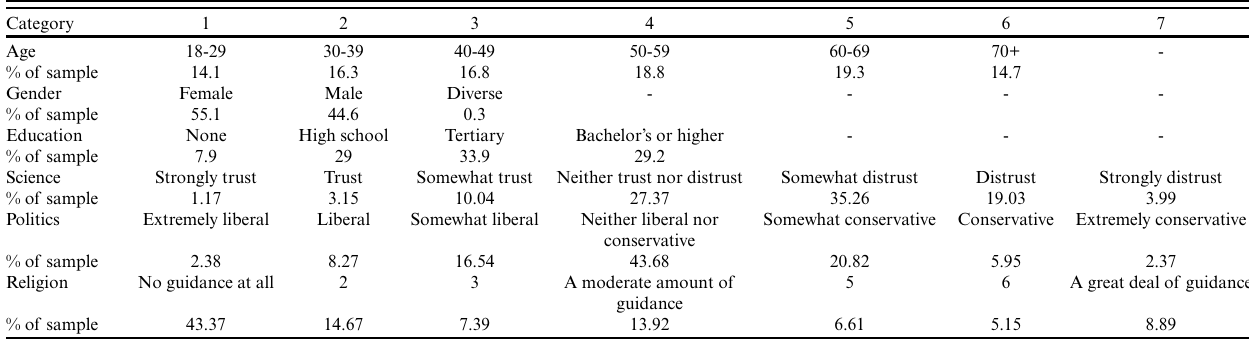
Table 1 . Description of demographic and psychometric